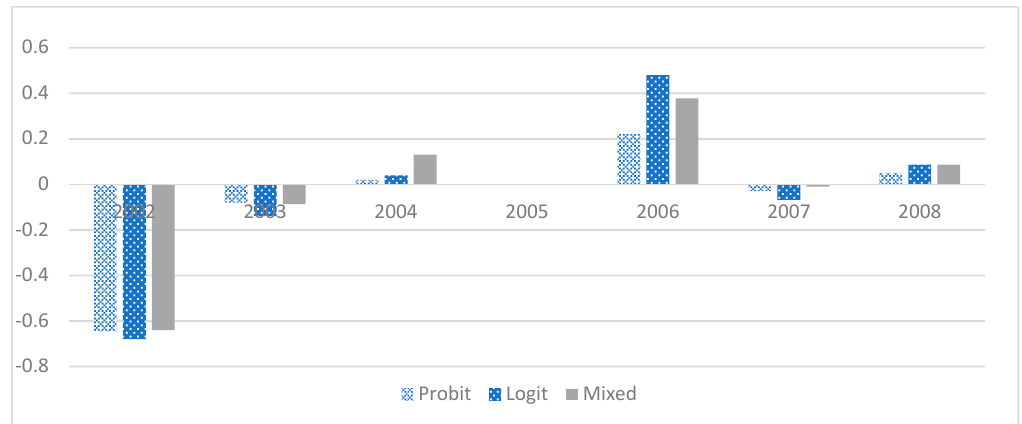
Figure 1. The effect of the 2005 policy change on the probability of VBAC. Note: Y axis shows Figure 1. The e ff ect of the 2005 policy change on the probability of VBAC. Note: Y axis shows coefficients from different regression models. In the Probit model, coefficients represent probability coe ffi cients from di ff erent regression models. In the Probit model, coe ffi cients represent probability of of using natural delivery. In the logit and mixed models, coefficients represent log odds ratio. using natural delivery. In the logit and mixed models, coe ffi cients represent log odds